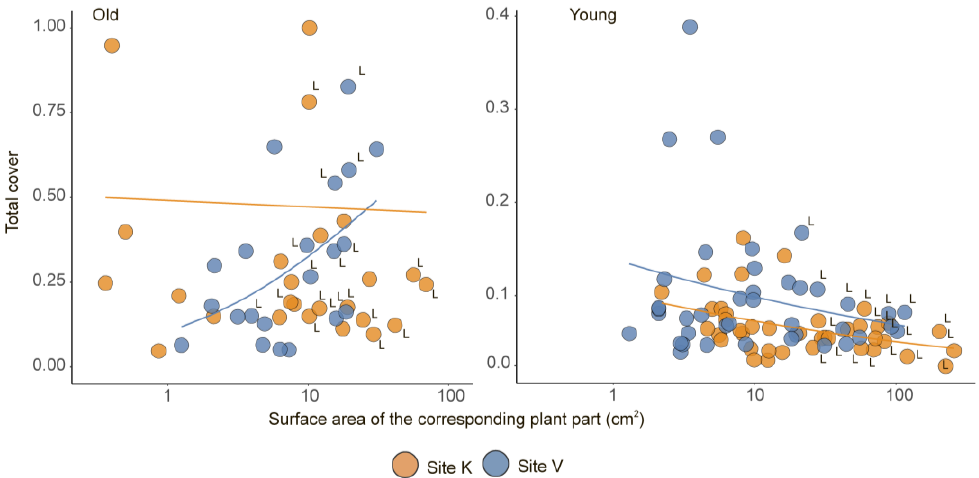
Figure 3. Total percent cover of epibiosis on young and old parts of Phycodrys rubens in September 2015 by surface area of these parts. ‘L’ marks auxiliary non-randomly sampled 5 largest plants per frame. Fit lines plotted according to significant relationships (see Table 5 for details on beta-regression models).